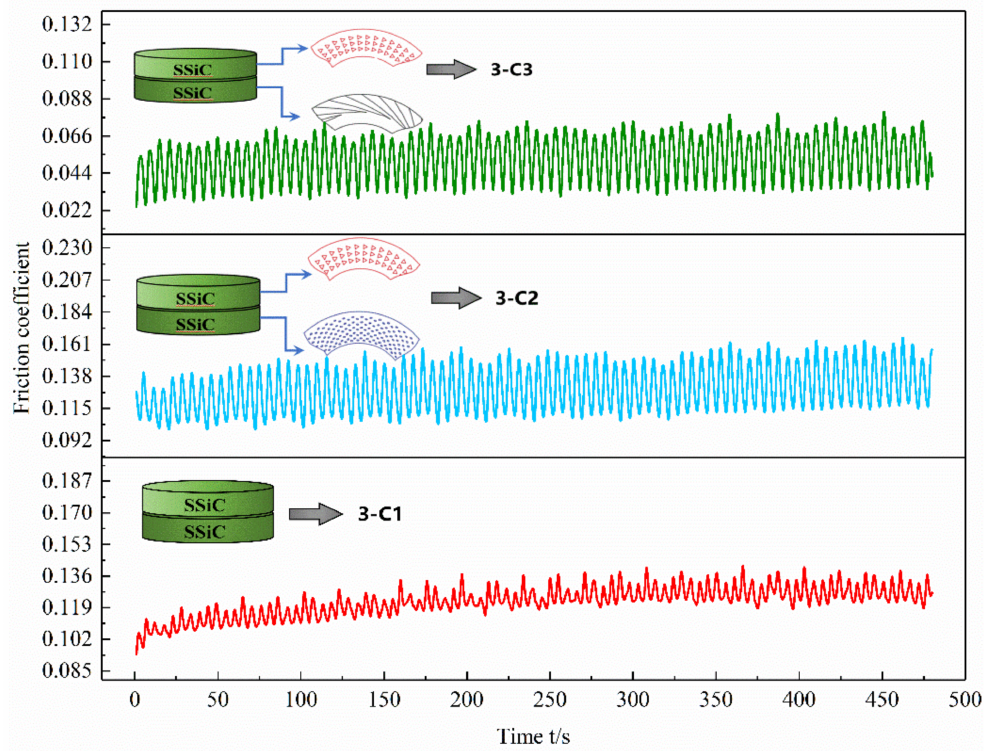
Figure 10. Real-time friction coefficient of friction pairs with bi-composite surface texture configura- tions under 250